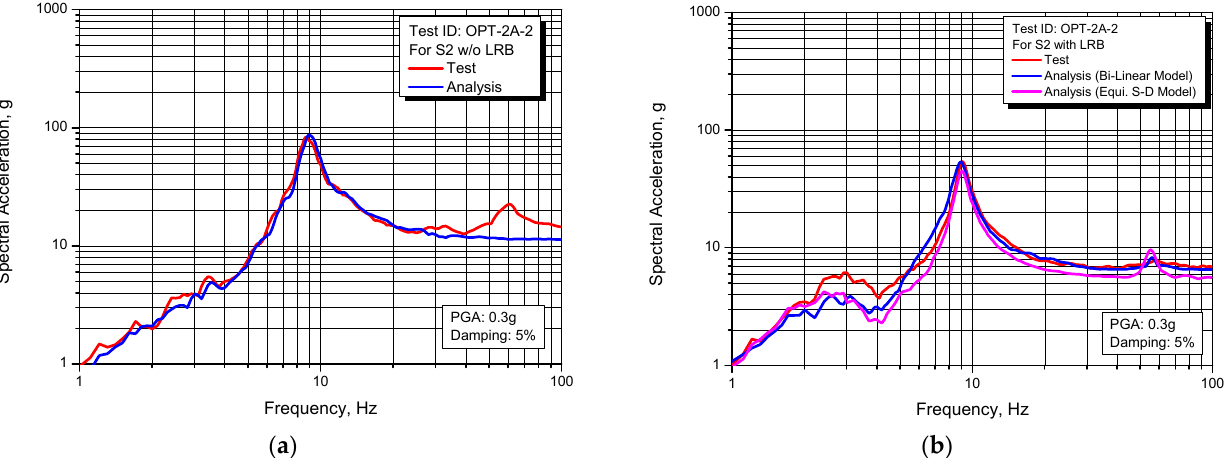
Figure 20. Comparison of response spectrum between test and analysis for S2 structure: ( a ) Non-isolated; ( b ) Seismically isolated.